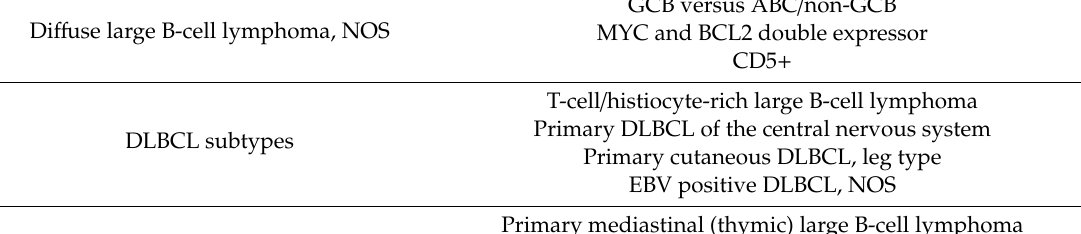
Table 1. 2016 update of WHO classification of DLBCL: subtypes and related entities [4]. Di ff use large B-cell lymphoma,